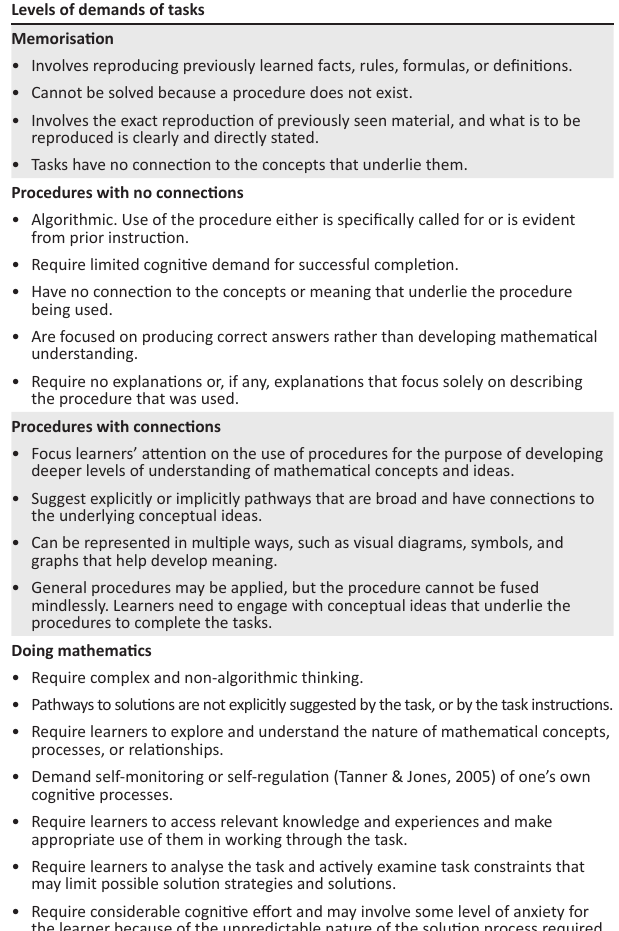
TABLE 1: Cognitive demand levels used in mathematical task